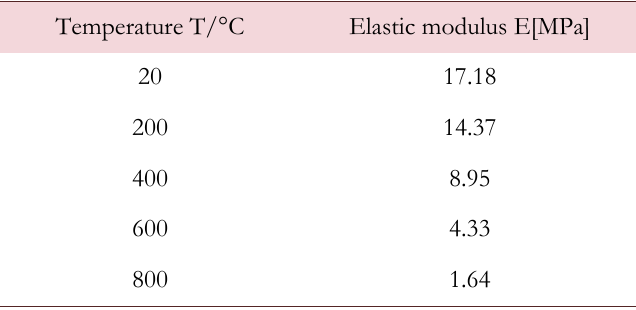
Table 1: Standard elastic modulus obtained after